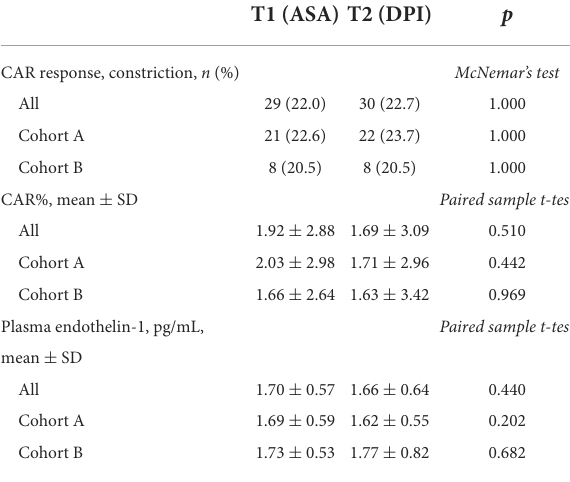
TABLE 3 The effect of DPI on endothelial dysfunction as represented by the CAR response, CAR%, and plasma endothelin-1 levels. T1 (ASA) T2 (DPI)